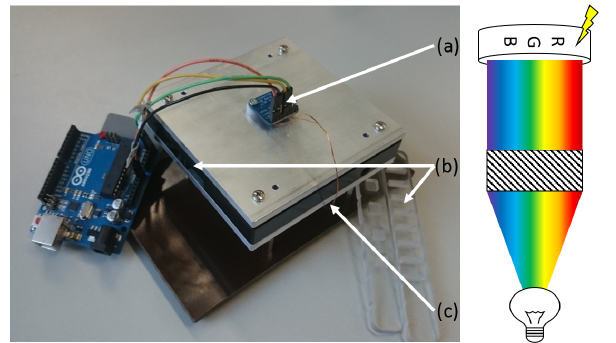
Figure 4. Picture of the prototype for transmitted light measure- ments consisting of (a) RGB detection unit, (b) a sample holder and (c) a LED. The diagram on the right shows the measurement